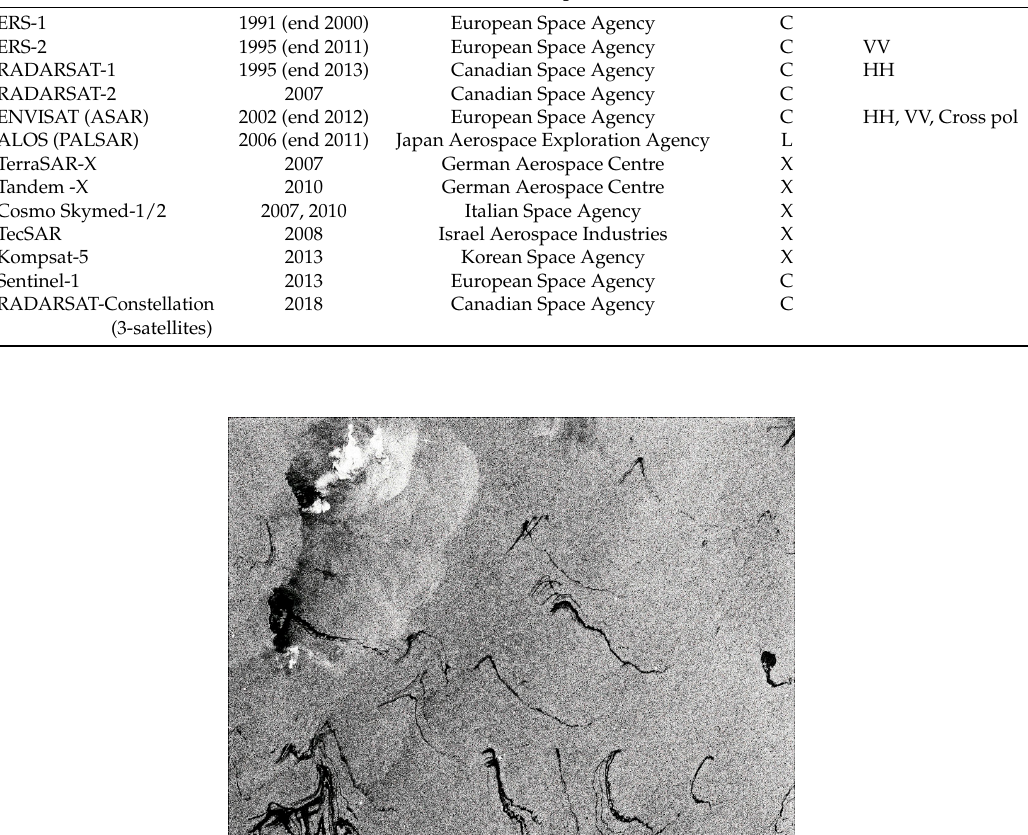
Table 1. Satellite-borne synthetic aperture radar (SAR) sensors—current and future.